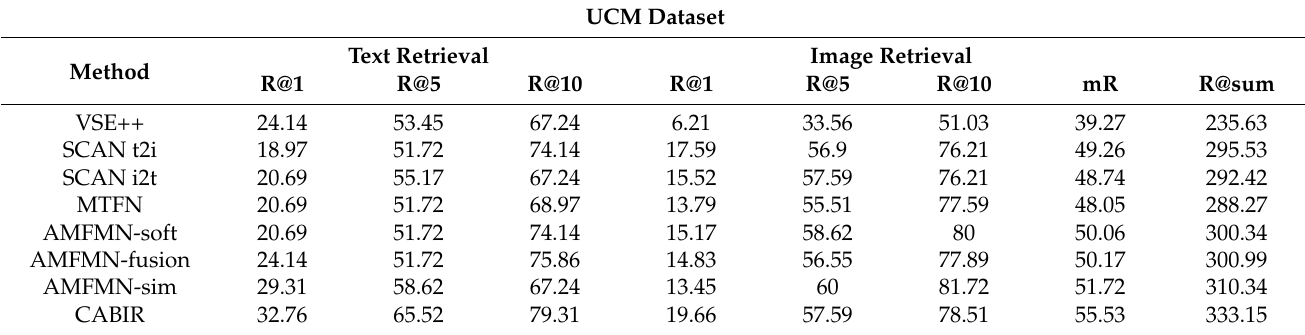
Table 3. Comparison of results of all models on the Sydney-Captions